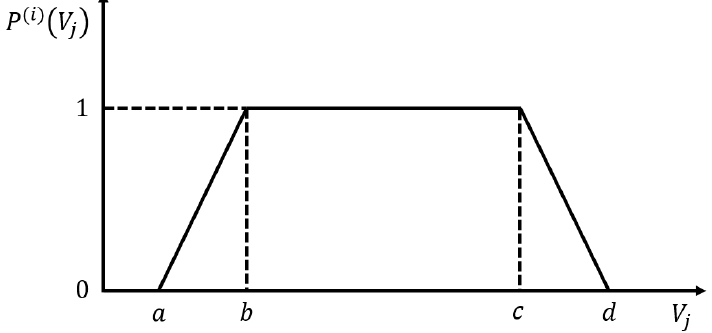
Figure 4. Typical trapezoidal MF of the fuzzy logic